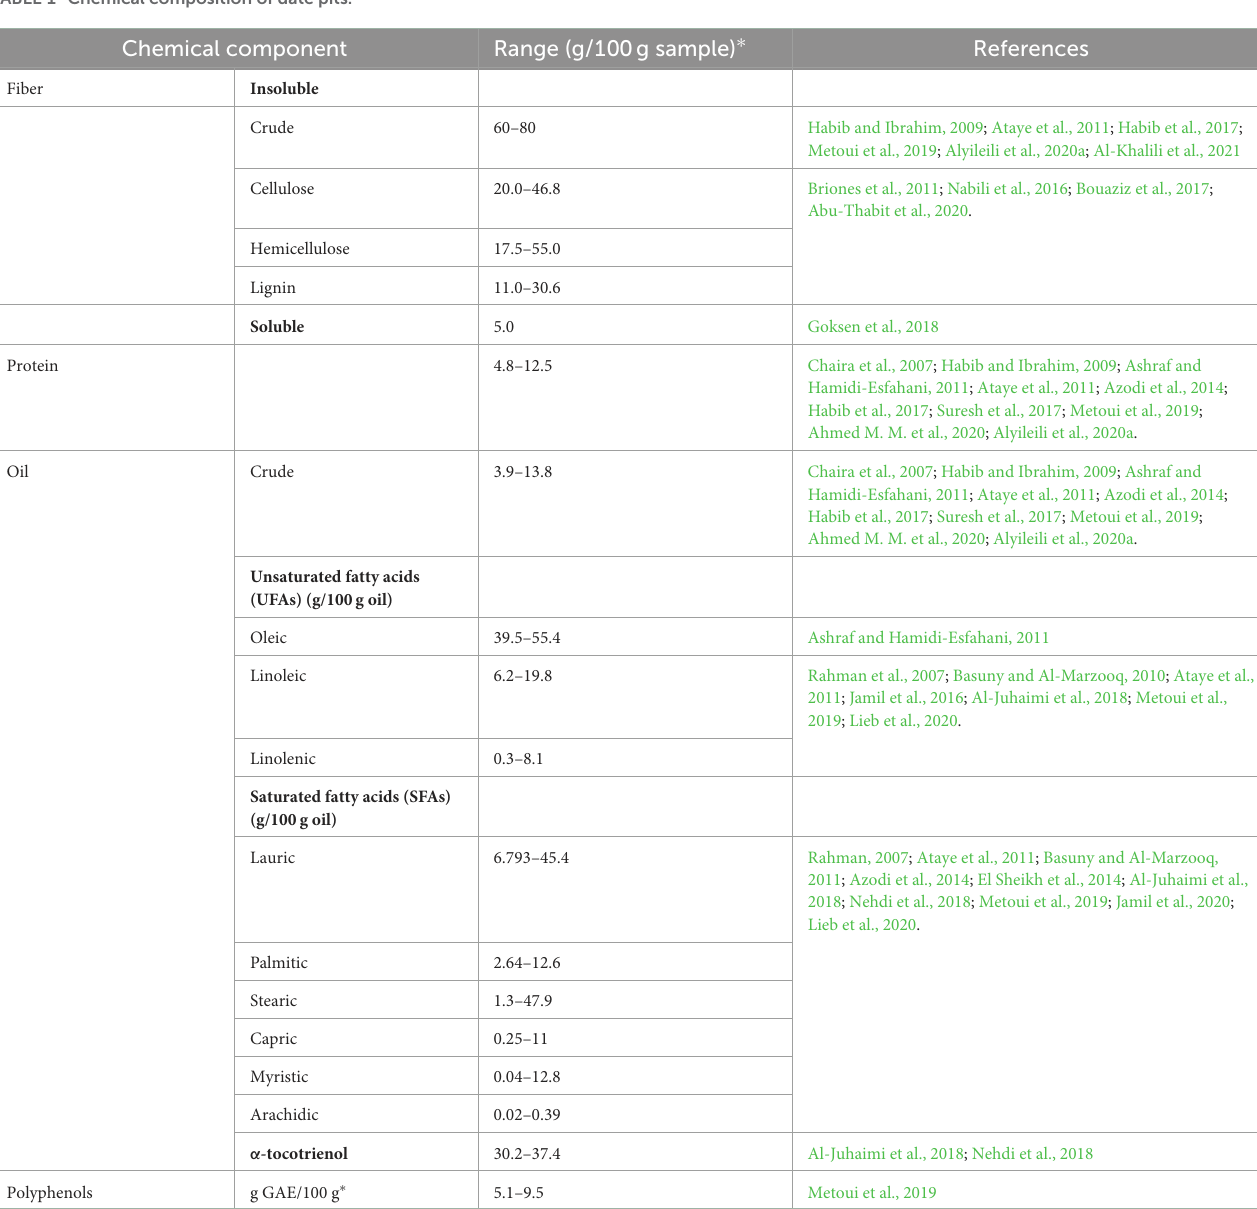
TABLE 1 Chemical composition of date